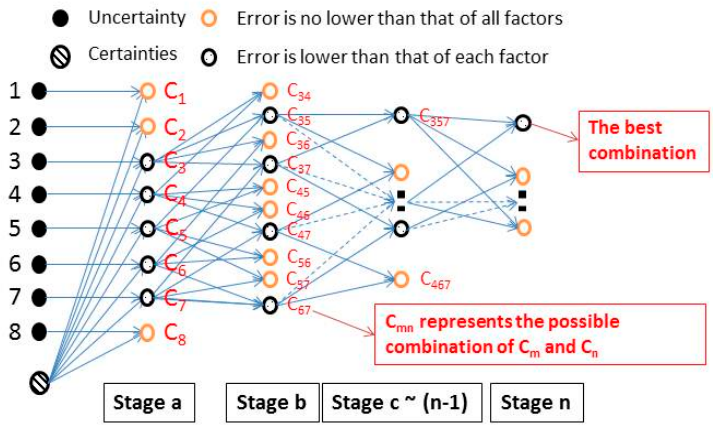
Figure 3. The determination of the best combination of input variables.